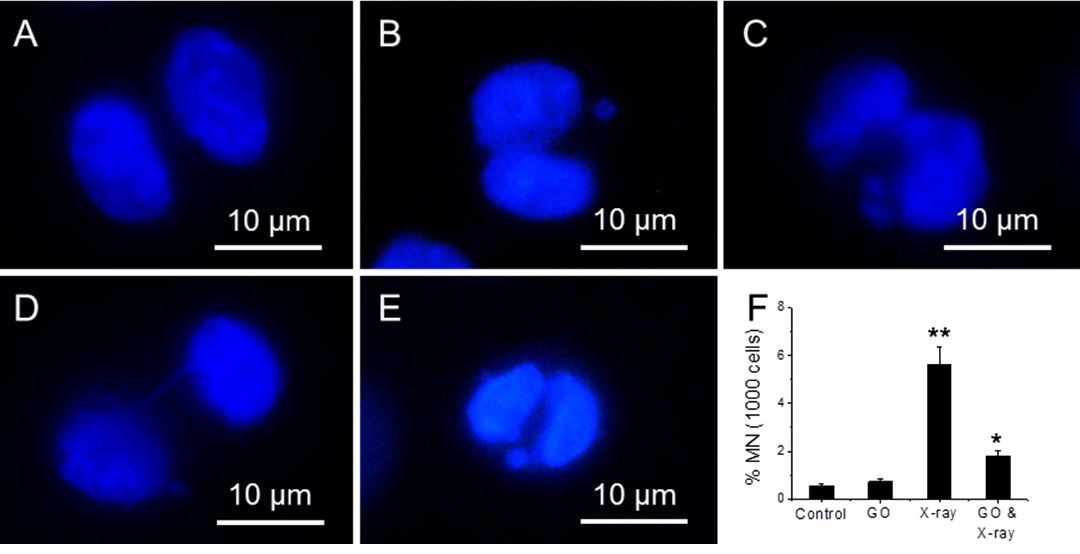
Figure 6. Fluorescence images of cells exposed to X-ray, where a bi-nucleated fibroblast has no micronucleus ( A ); one micronucleus ( B ); two micronuclei ( C ); a nucleoplasmic bridge (NPB) ( D ); and a nuclear bud (NBUD) ( E ); the appearance frequency of micronucleus of four samples ( F ), where cells are arrested at inter-phase stage. “ * ” ( p < 0.05) and “ ** ” ( p < 0.01) represent significant difference and extra significant difference,